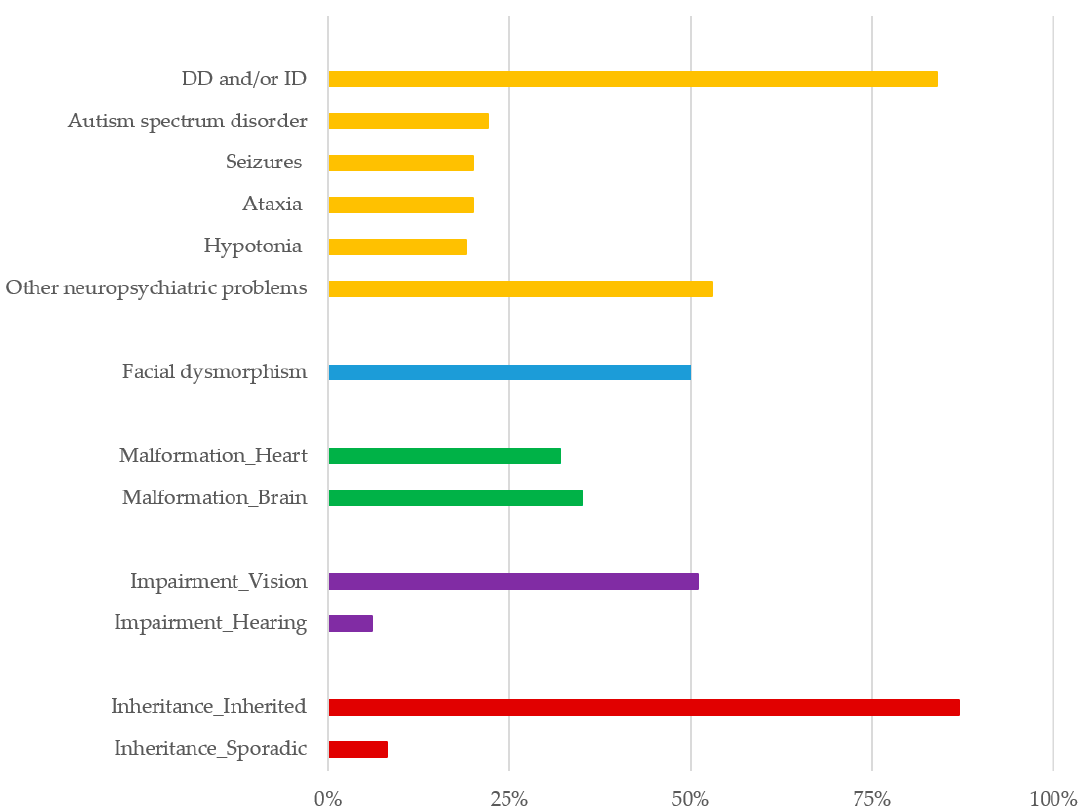
Figure 2. Literature review of the clinical characteristics and frequencies in 141 reported cases with 15q11.2 breakpoint (BP) 1 and BP2 deletion [4–7,12–16]. DD, developmental delay; ID, intellectual disability.